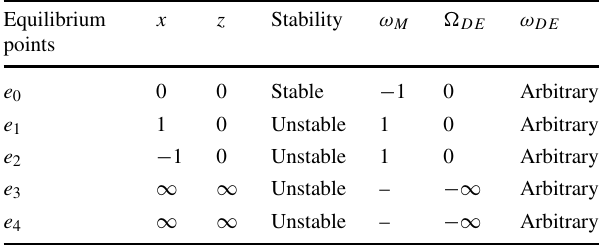
Table 2 Equilibrium points and their characteristics on the invariant plane s = 0 Equilibrium points